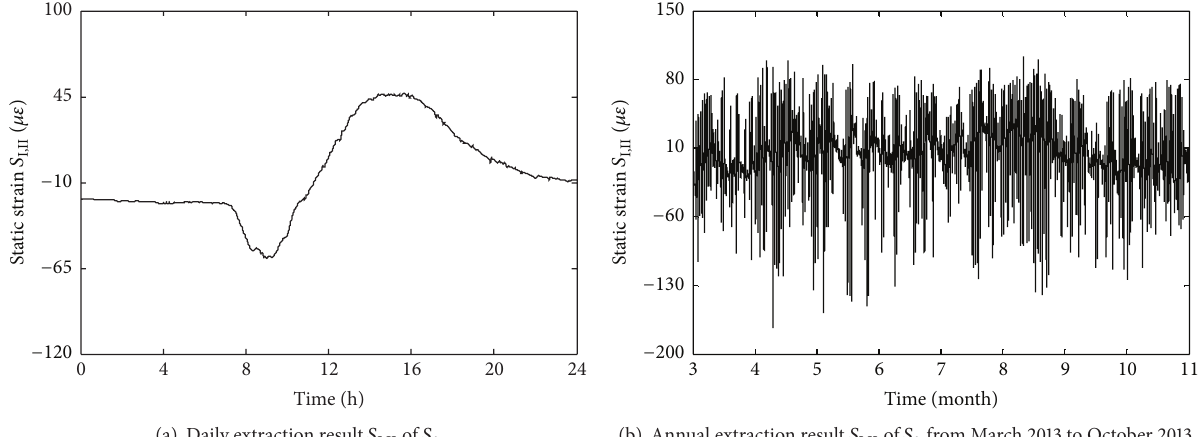
Figure 15: Extraction results 𝑆 I , II of static strain data 𝑆 1